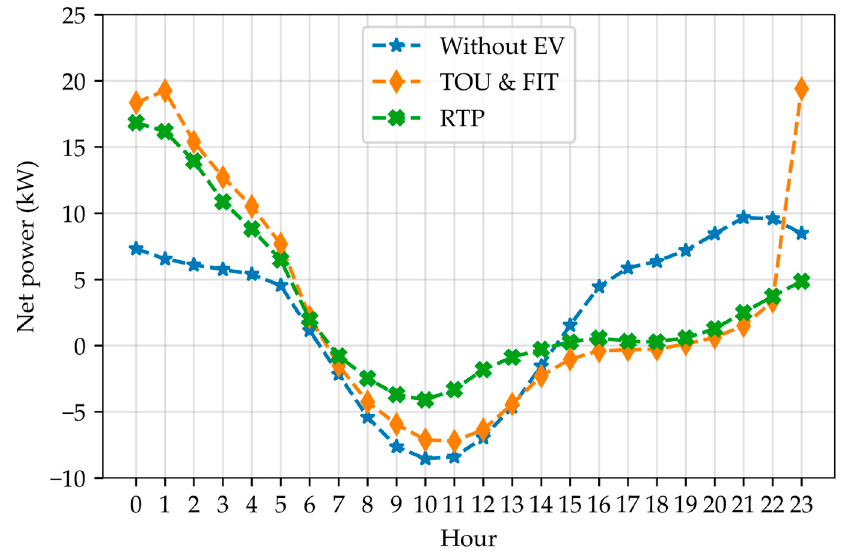
Figure 9. The hourly mean of the net power of the aggregator.